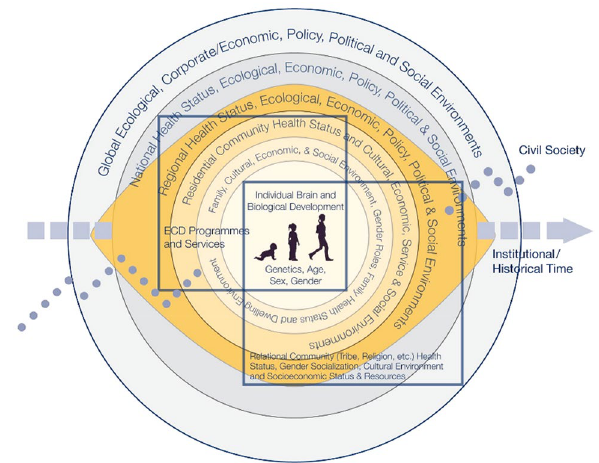
Fig. 1 Total environmental assessment model for early child development (Irwin et al.,